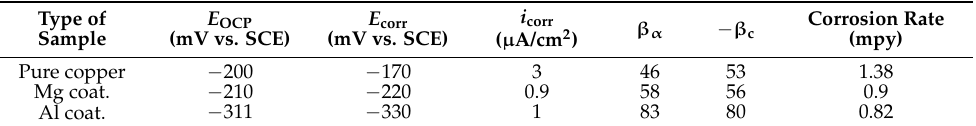
Table 3. OCP ( E OCP ), corrosion potentials ( E corr ), corrosion current densities ( i corr ), Tafel slopes and corrosion rates of uncoated and Mg, Al coated samples in 3.5 wt.% NaCl aqueous solution at 25 ◦ C (mean values with standard deviation for potentials <7% and for current densities <5%).